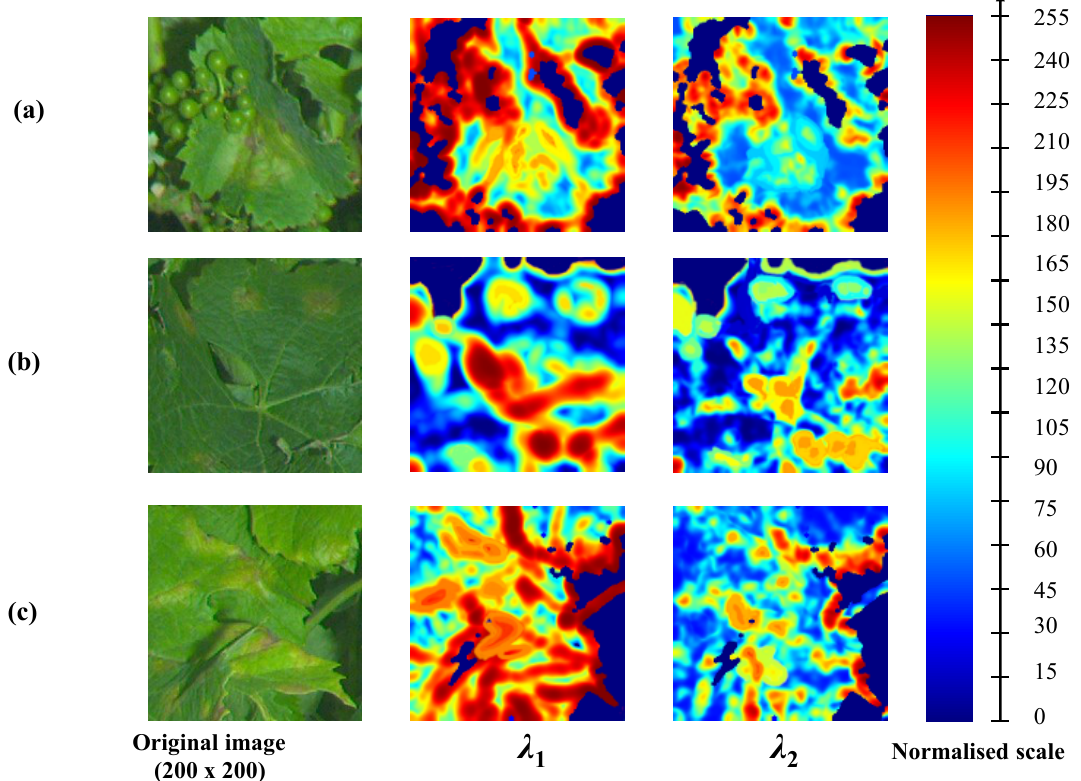
Figure 5. Discriminative properties of LST: separability of visible foliar symptoms of downy mildew on the basis of the λ 1 and λ 2 eigenvalues of the tensor. Eigenvalues are displayed on a normalised 8-bit colour scale. Three “textbook” cases are presented, ( a ) a large circular “oilspot”, ( b ) a “crown of oilspots” and ( c ) irregular symptoms on the edges of the